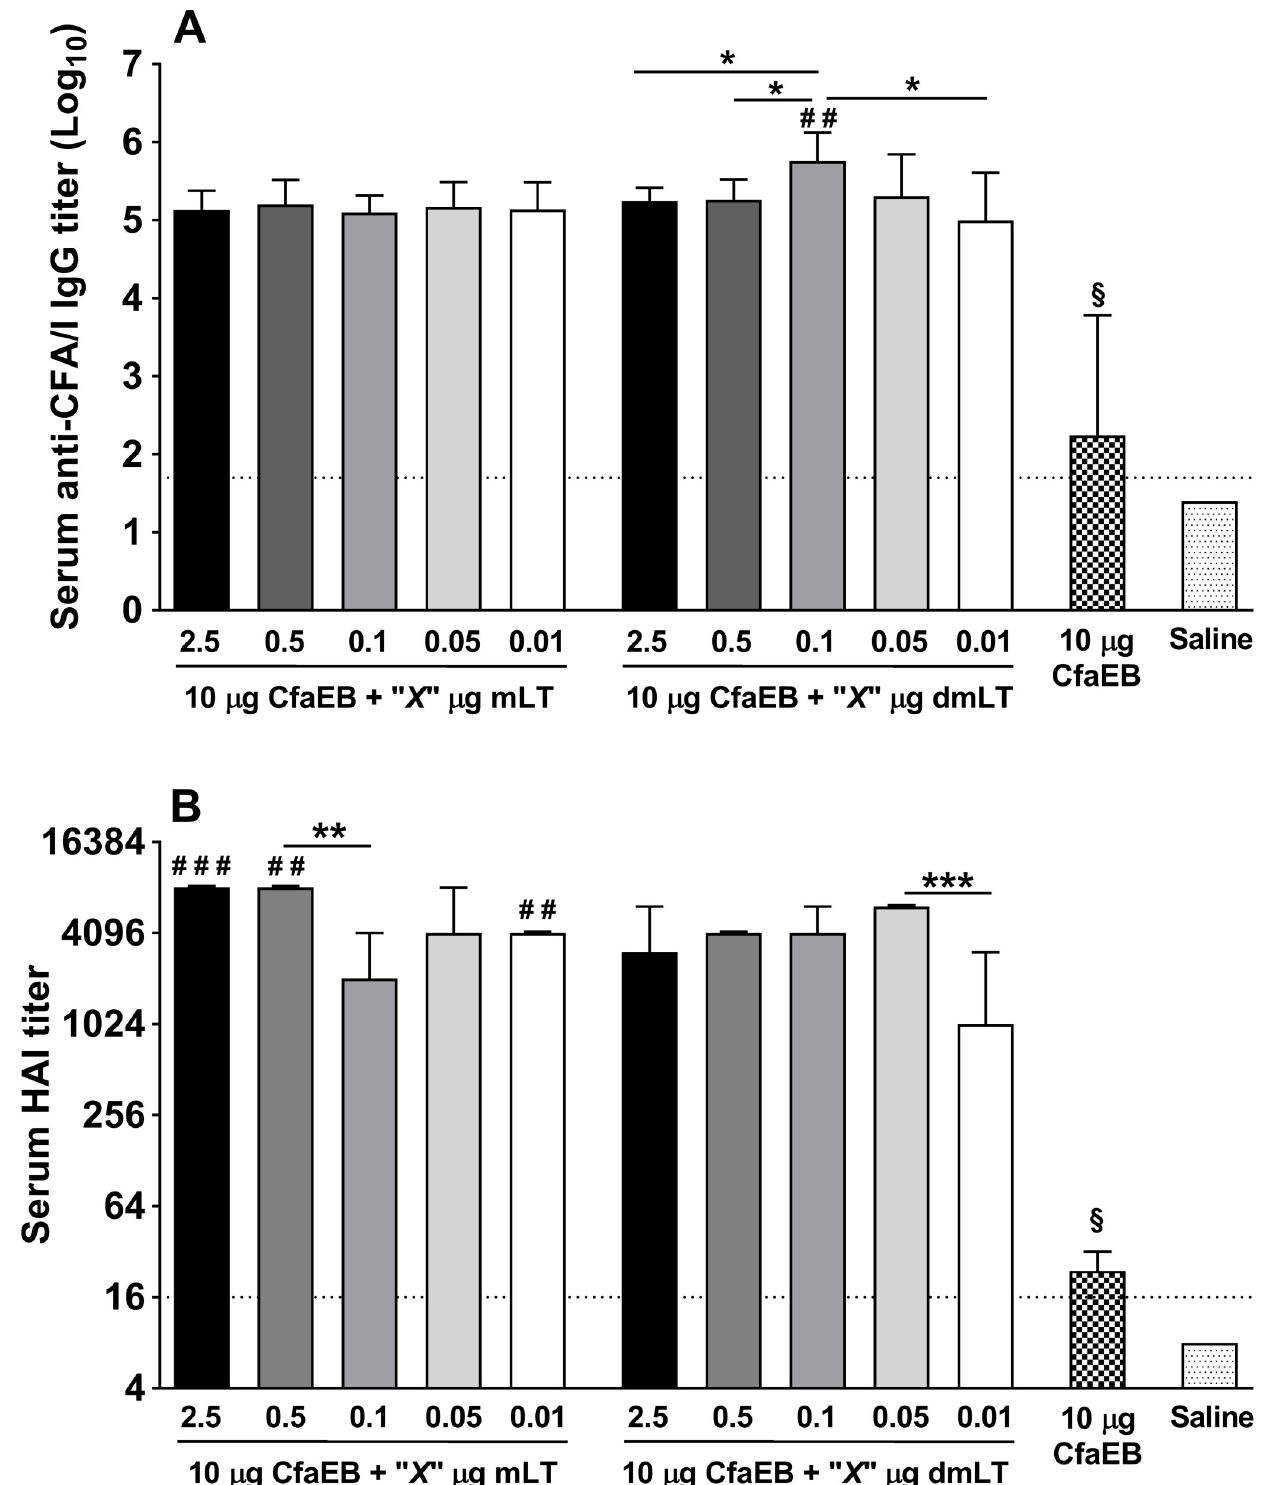
Fig 5. Evaluation of anti-CFA/I IgG and functional neutralizing antibodies against CFA/I + ETEC (strain H10407). Data are from d42 sera. (A) Geometric mean titers (+95% confidence interval) of log 10 transformed of anti-CFA/I IgG Ab titers on d42 for all groups (n = 5/group); (B) Functional neutralizing antibodies against CFA/I + ETEC strain H10407; bars represent the median ± ranges for each group (n = 5/group). Dotted horizontal line